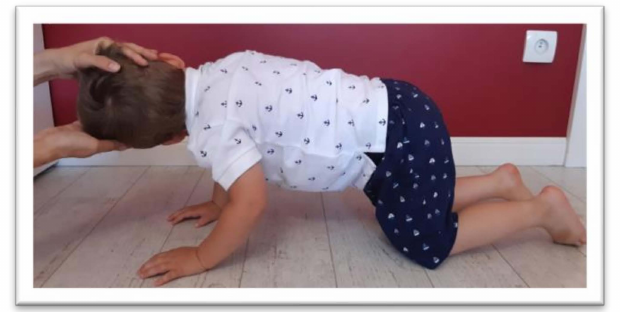
Figure 6. Position for the examination of ATNR for the left side.